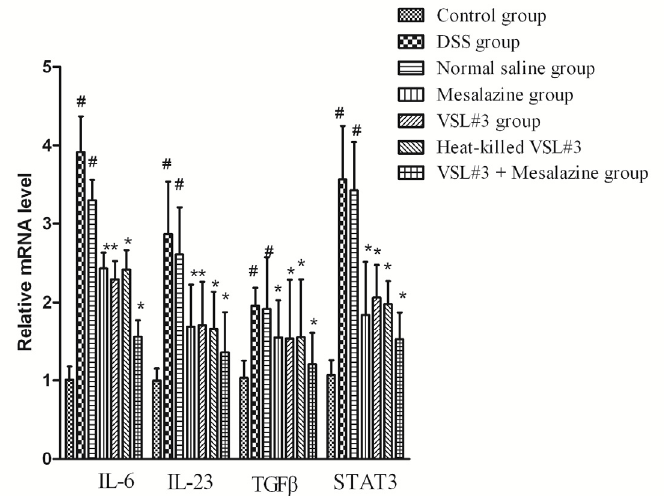
( # p < 0.05 versus control group; * p < 0.05 versus DSS